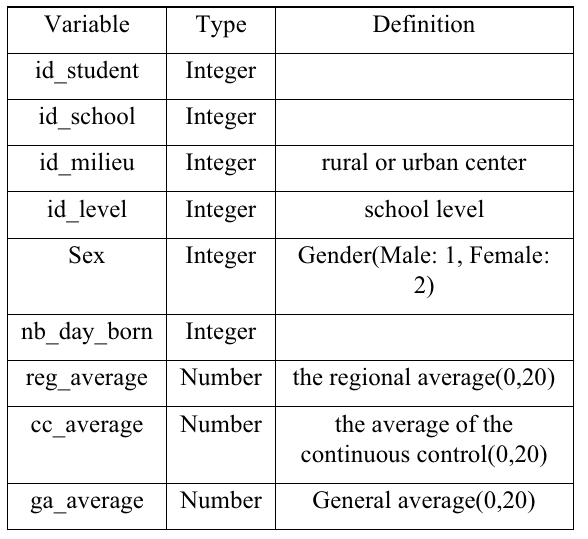
Table 1. Dataset description